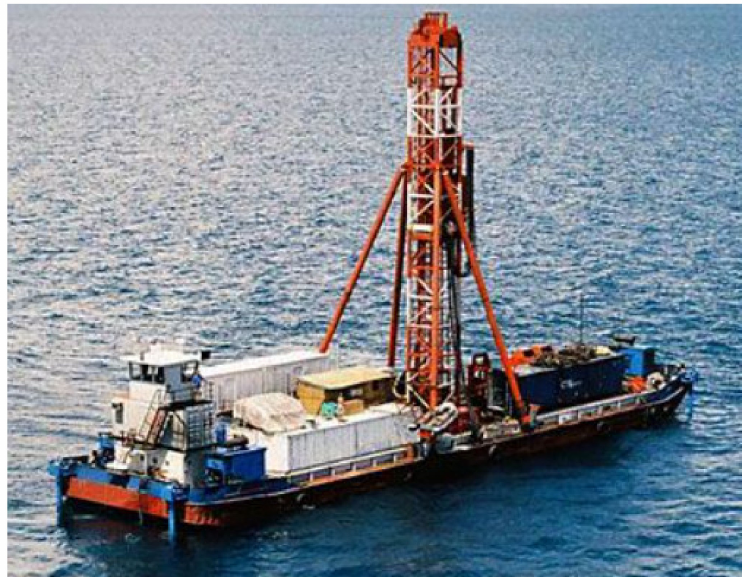
Figure 7. Drilling barge.